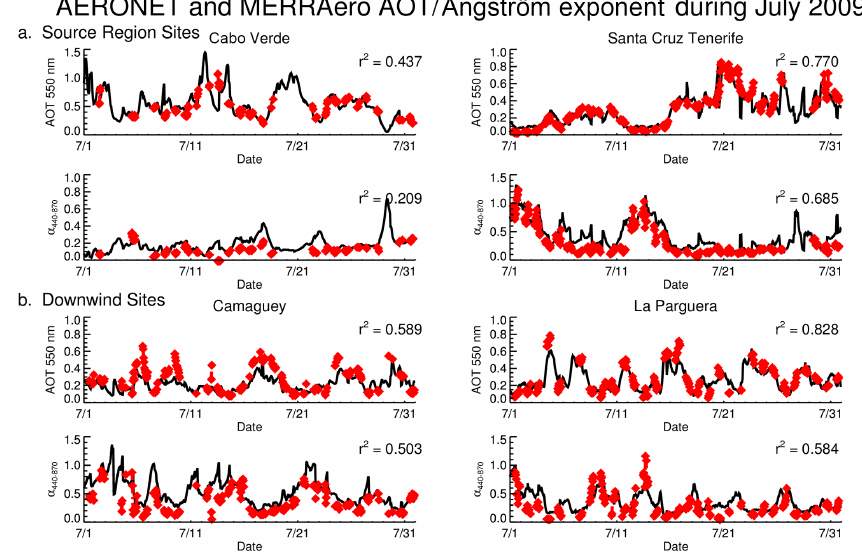
Figure 3. AERONET (red) comparisons to MERRAero (black) AOT and Ångström exponent at sites near the source region (a) and downwind in the Caribbean (b) .